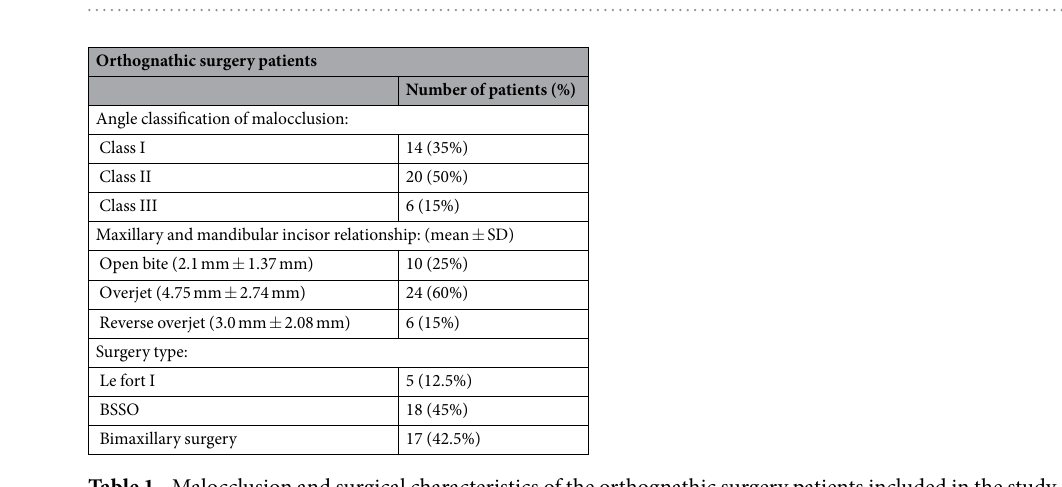
Figure 2. Occlusal force distribution using T-Scan III, Software version 8.0.1. ( a ) Two-dimensional and ( b ) three-dimensional images of a healthy participant.